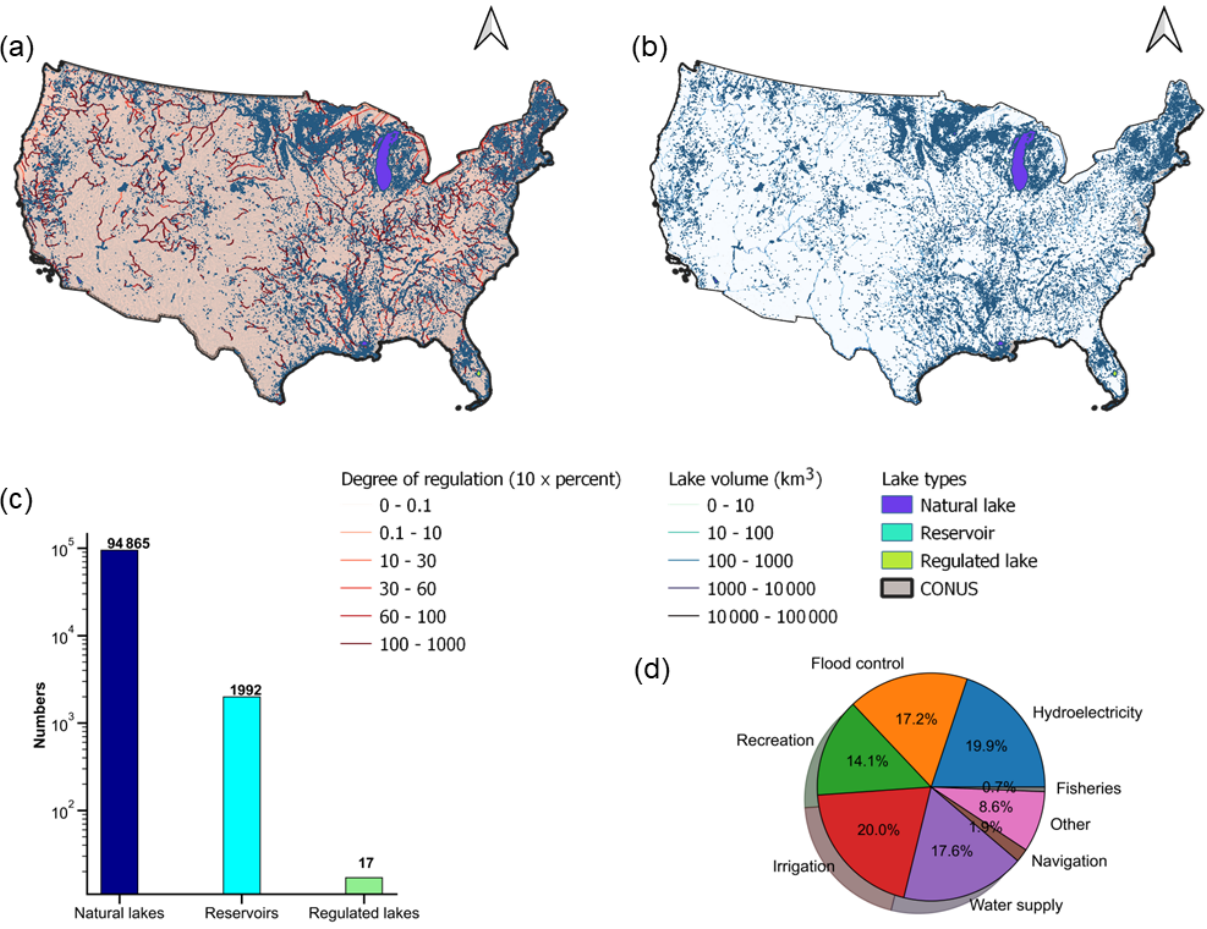
Figure 1. Maps of (a) percentage of regulated river and (b) regulated lake volume; (c) bar plot of lake classifications; (d) pie plot of US regulated lake or reservoir function